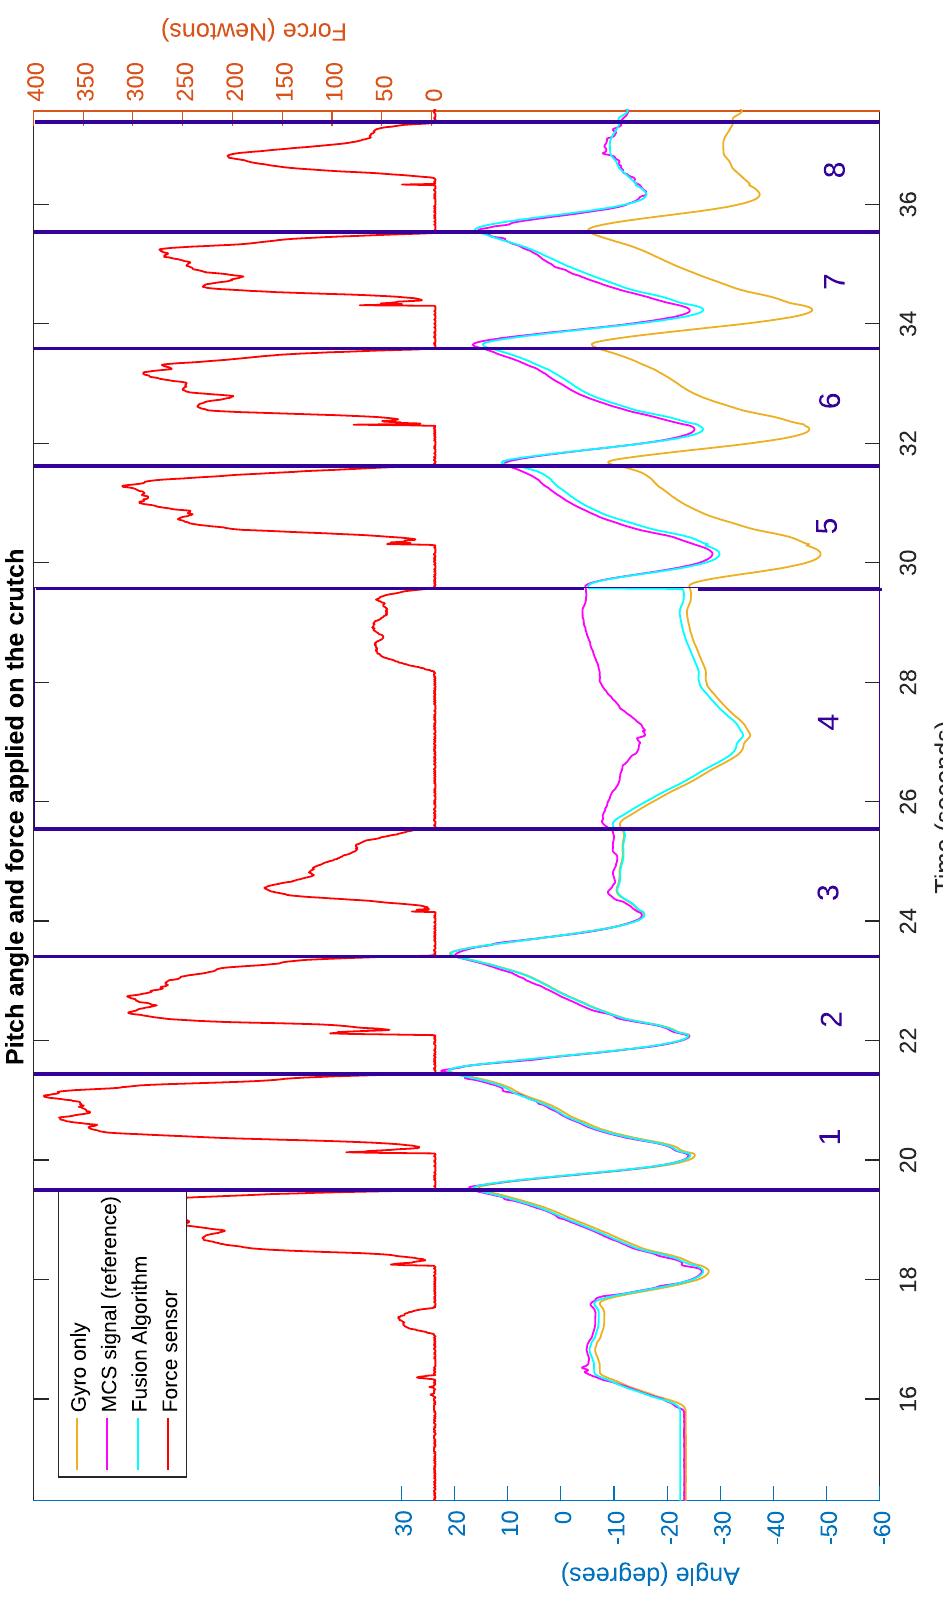
Figure 10. Estimated pitch angle obtained applying the presented